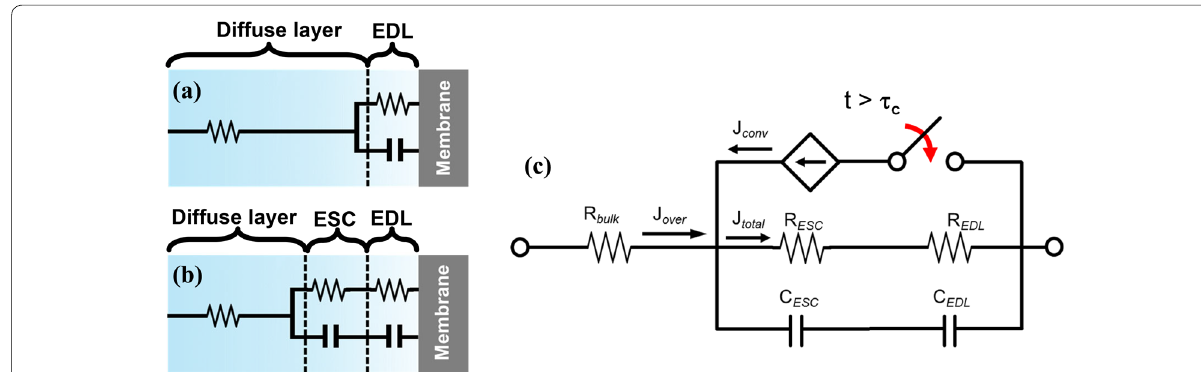
Fig. 4 Schematics of equivalent circuit of ICP layer at a ohmic current regime and b overlimiting current regime. c A unified equivalent electrokinetic circuit model of ICP layer considering EDL, ESC and 2nd